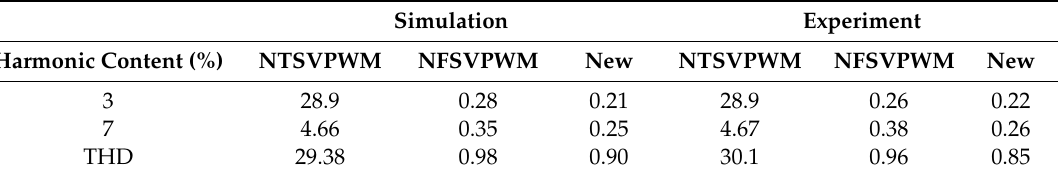
Table 3. Simulation and experimental data for m = 1.0514.